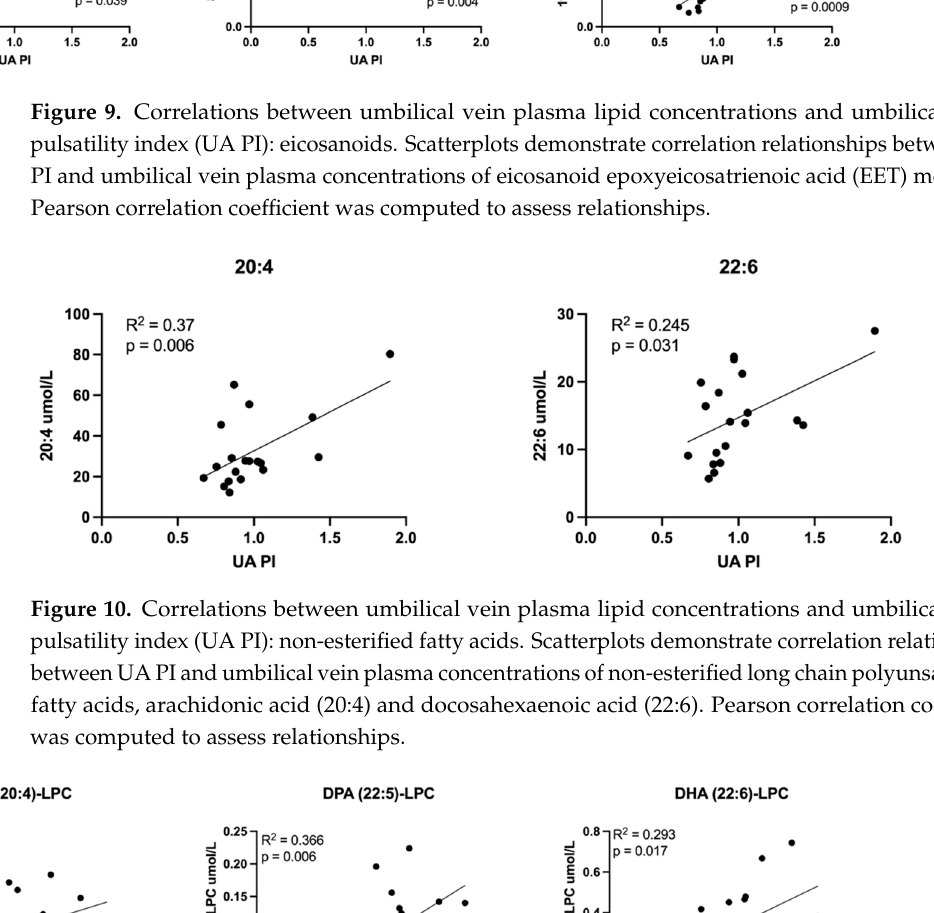
Figure 11. Correlations between umbilical vein plasma lipid concentrations and cerebroplacental ratio (CPR). Scatterplots demonstrate direct correlation between CPR (ratio of MCA PI divided by UA PI) and umbilical vein plasma concentrations of long chain polyunsaturated fatty acid (LCPUFA)-lysophosphatidylcholine (LPC) molecules. Abbreviations: AA, arachidonic acid; DPA, docosapentaenoic acid; DHA, docosahexaenoic acid; MCA PI, middle cerebral artery pulsatility in- dex; UA PI, umbilical artery pulsatility index. Pearson correlation coefficient was computed to as- sess relationships.